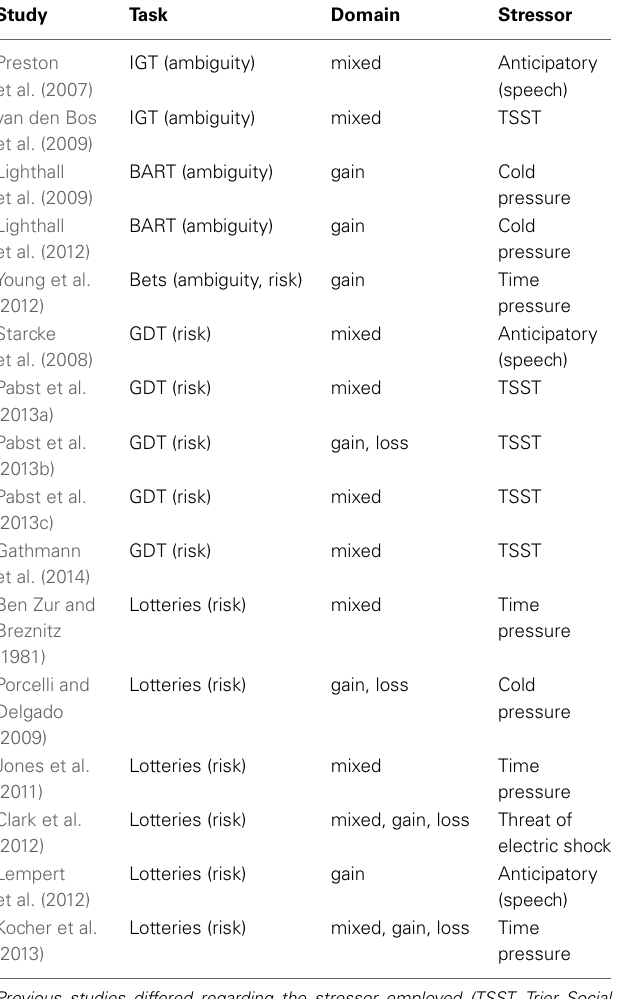
Table 1 | Previous studies of stress effects on decision making under